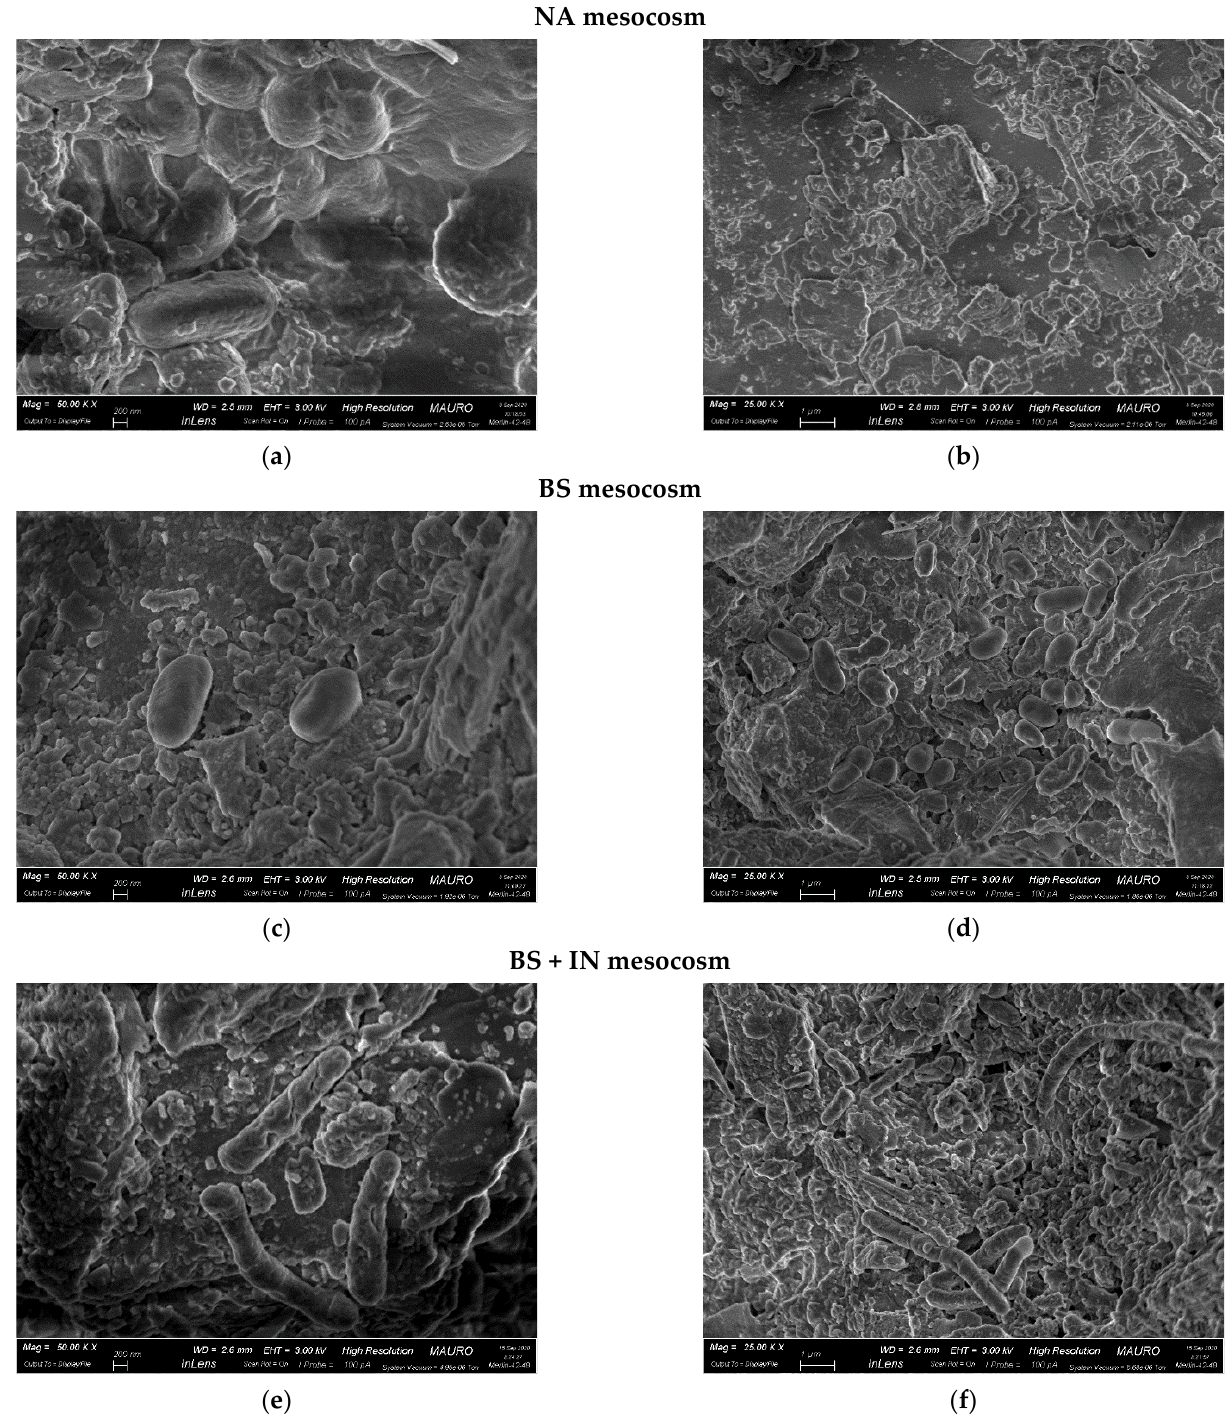
Figure 6. SEM images for: ( a ) central and ( b ) bottom zone of NA mesocosm; ( c , d ) superficial zone of BS mesocosm; and ( e , f ) superficial zone of BS + IN mesocosm. For the NA microcosm, the presence of microorganisms was evidenced in the centre of the column (Figure 6a); however, on the bottom, no microbial species seem present (Figure 6b).